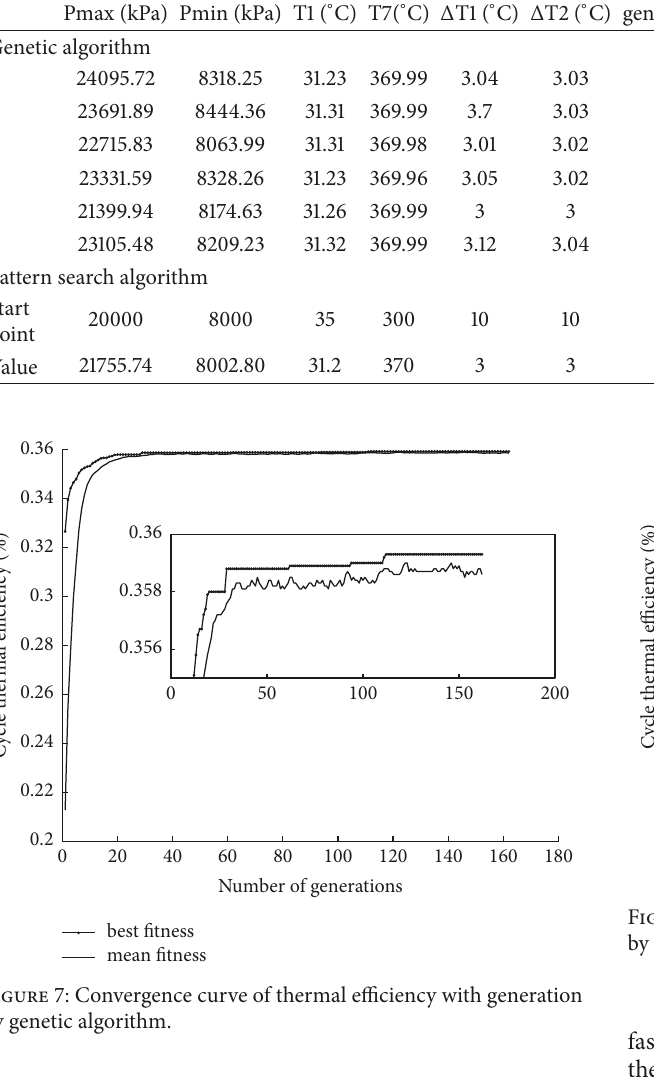
Table 3: Optimization of parameters by genetic algorithm and pattern search algorithm.